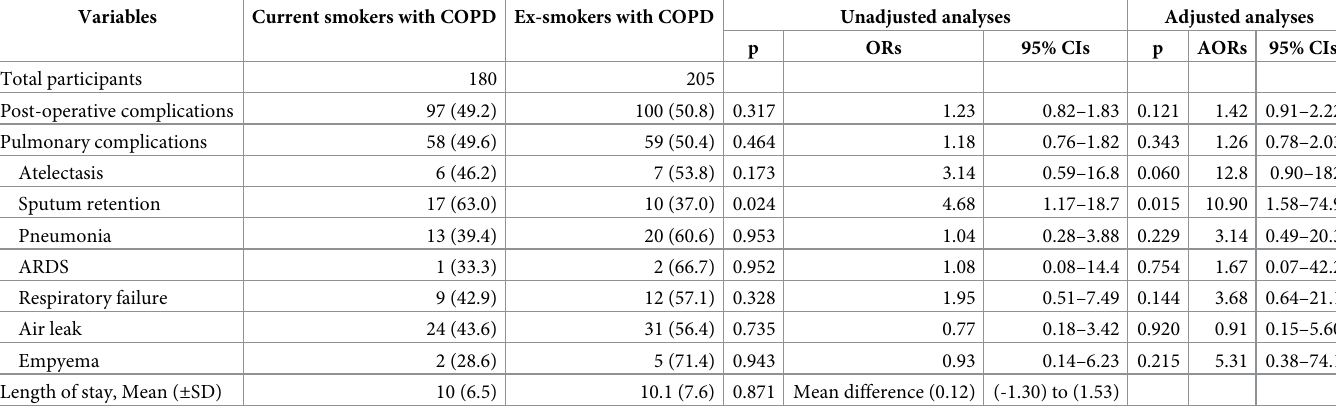
Table 5. Complication rates grouped by smoking status (current and ex-smokers) amongst COPD patients.